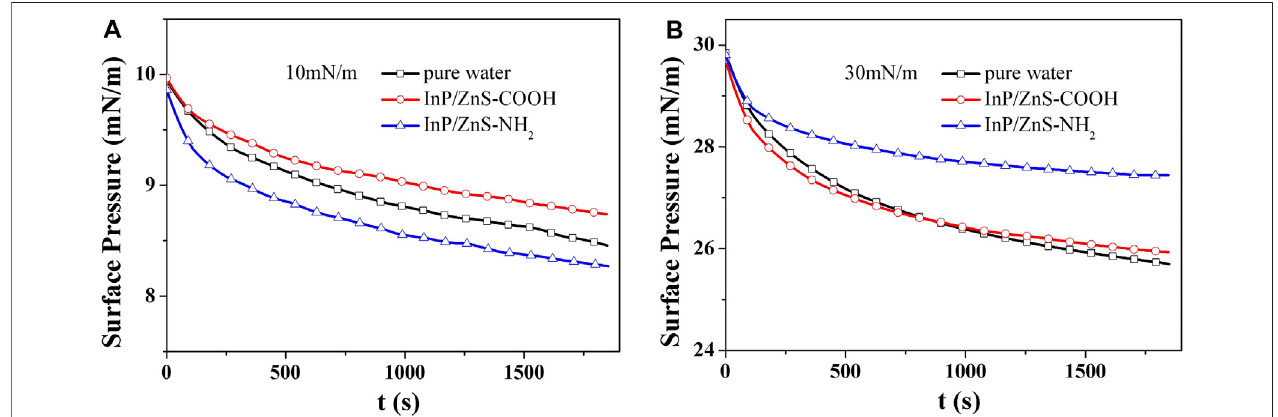
FIGURE 5 | Surface pressure-time ( π − t ) curves of DPPC/DPPG (4:1, mol/mol) monolayers at the initial surface pressure of 10 mN/m (A) and 30 mN/m (B) on subphase of pure water and with 0.2 μ g / mL InP/ZnS ( − COOH, − NH 2 ) QDs at 35.0 ± 0.5 ° C.